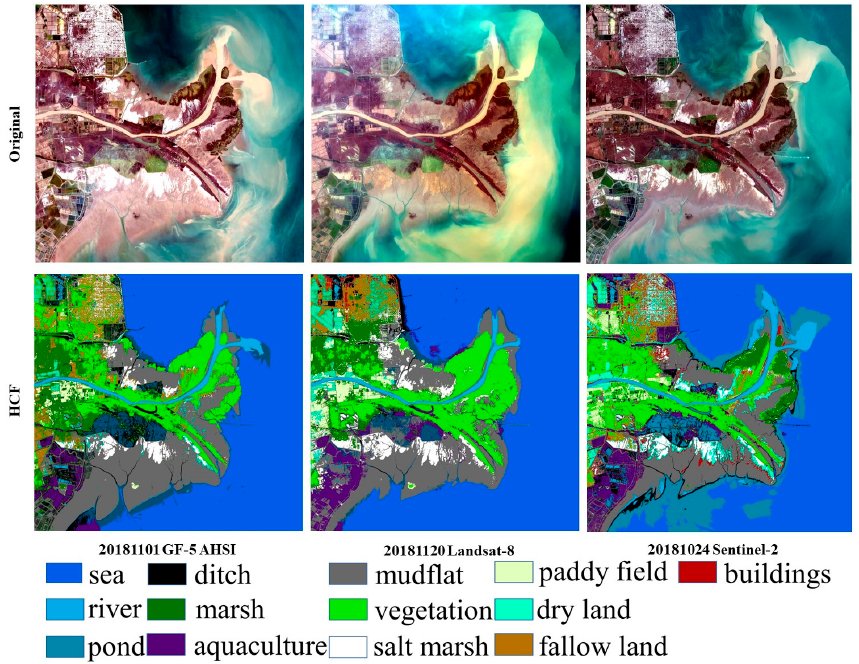
Figure 7. The comparison of PA and UA between HCF on the Yellow river estuary Landsat-8, Sentinel-2 and GF-5 AHSI data.